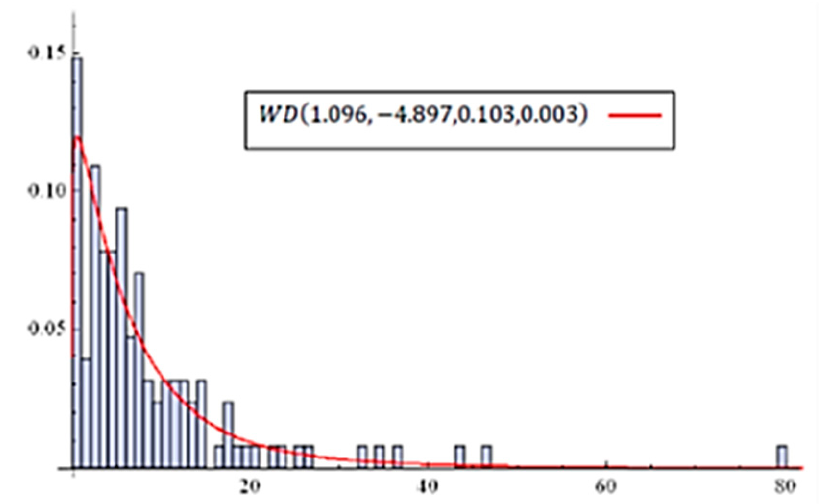
Figure 6. Estimated density of WD ( α , β , γ , λ ) for data set 2. According to the Vuong test, we can conclude that WD fits the data better than the normal distribution and Johnson’s S L with (V = 4.47 with p -value < 0.001) and (V = The variance covariance matrix 𝐼(𝜃) (cid:2879)(cid:2869) of the MLEs under the Whittaker distribution for data set 3 is computed as follows.